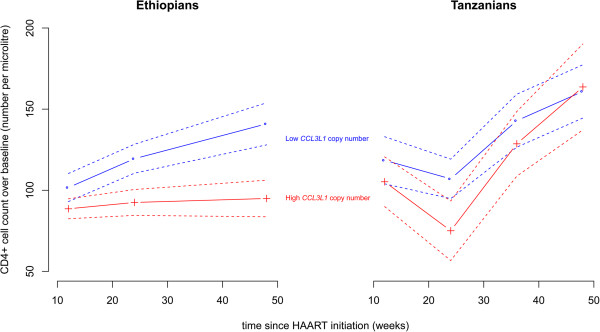
Response to HAART in Ethiopians and Tanzanians stratified by CCL3L1 copy number. Average values (solid line) and standard error of the mean (dashed line) of CD4+ cell counts was calculated for the different timepoints following initiation of HAART. Patients were stratified according to CCL3L1 copy number, with high copy number being greater than the median integer value, which was 3 copies in Ethiopians and 4 copies in Tanzanians. N = 798 CD4+ values in Ethiopians, n = 894 CD4+ values in Tanzanians.